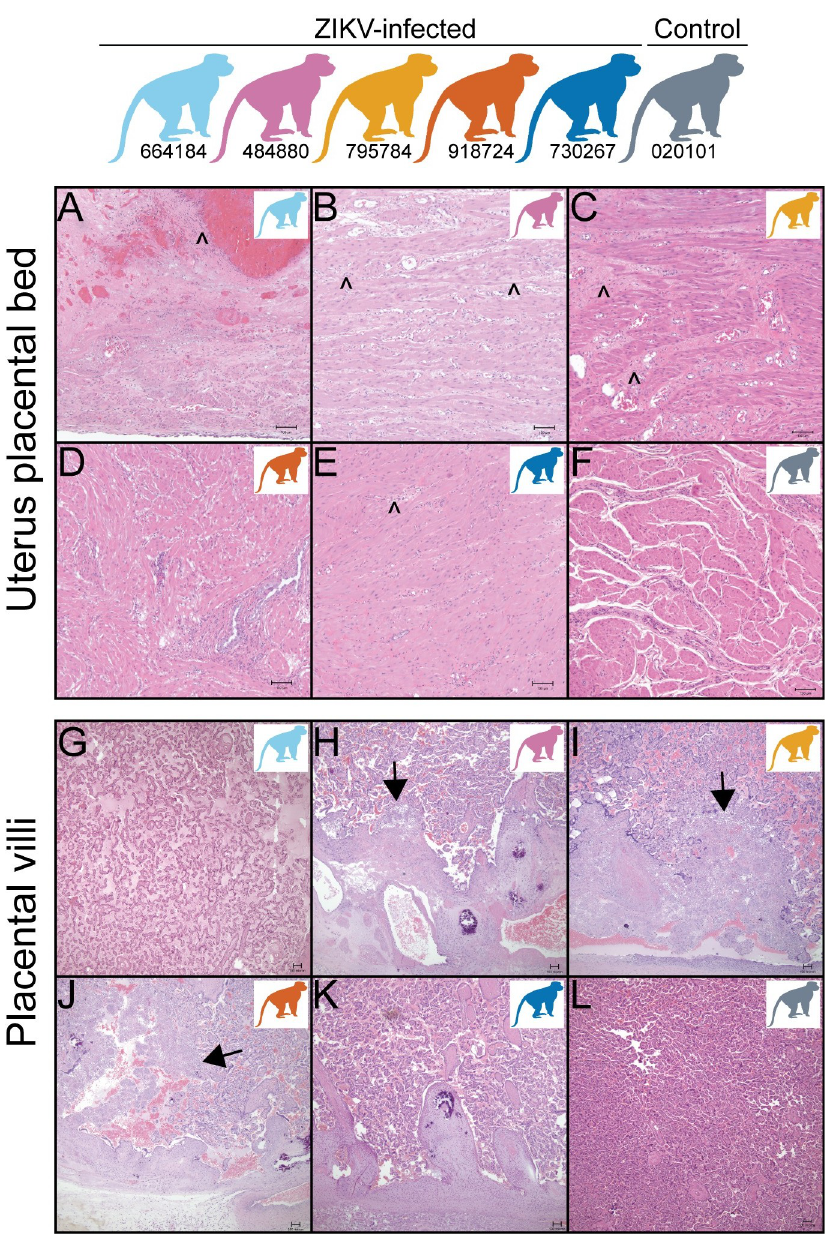
Fig 4. Placental bed and placental villous pathology. (A-F) Uterine placental bed histology reveals minimal to severe lymphoplasmacytic myometritis or neutrophilic to lymphoplasmacytic endometritis (caret symbol) in 4 of 5 ZIKV- exposed dams (A, B, C, E) but not in one of the ZIKV-exposed dams (D) or control decidua (F). (G-L) Within the placenta, 3 of the 5 ZIKV-exposed pregnancies have villitis (arrow heads) (H, I, J) but not in 2 of the ZIKV-exposed dams (G, K) or a control placental villi (L). Colors of macaques in each image represent individual animals as depicted at the top of the figure. Scale bar is 100 μ m. (d = 1.23) and cumulative feeding volumes (d = 0.9). We demonstrate that the sample size required to define differences between the weight gain trajectories in ZIKV-exposed and con- trol infants is 12 infants per group (Fig 6C). A larger group of infants (n = 21 per group) is required to define significant differences between cumulative feeding volumes (Fig 6C).